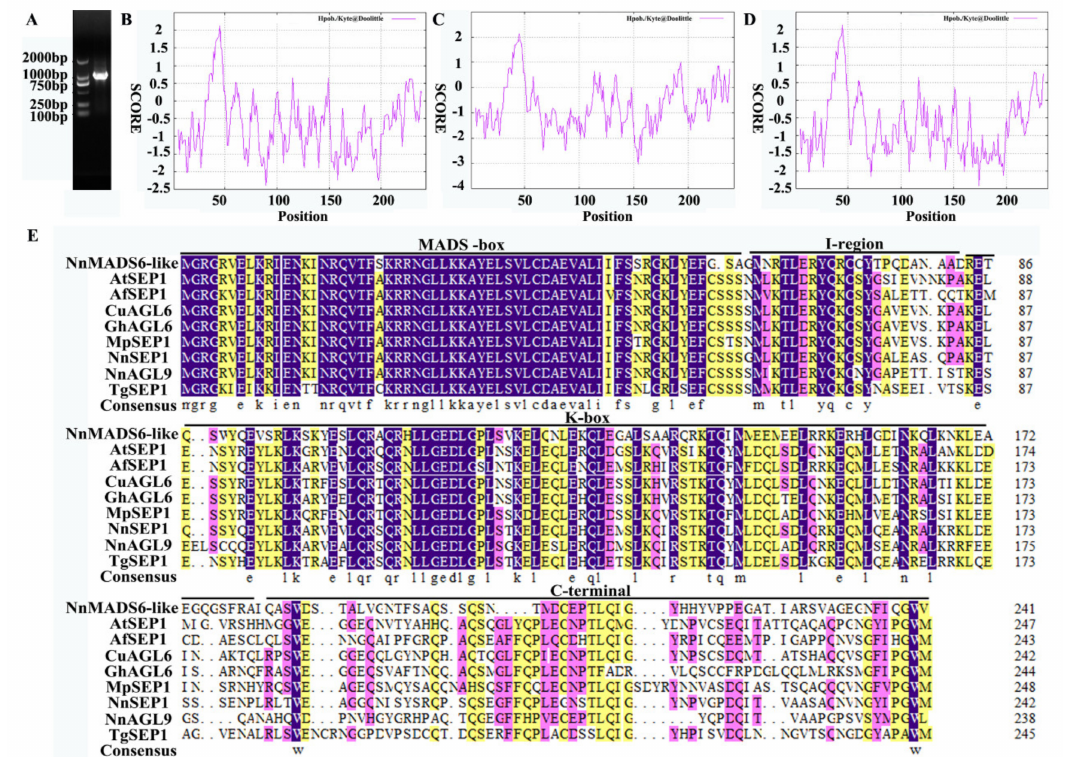
Figure 2. Cloning of three NnSEP genes and predictive analysis of their protein domains. ( A ) Cloning of the full-length cDNA of three NnSEP genes. ( B ) The prediction analysis of ProtScale protein hydrophobicity of NnSEP1. ( C ) The prediction analysis of ProtScale protein hydrophobicity of NnMADS6-like. ( D ) The prediction analysis of ProtScale protein hydrophobicity of NnAGL9. ( E ) Sequence alignment of SEP protein in Nelumbo nucifera and other species. The protein sequences of NnSEP1, NnMADS6-like and NnAGL9 aligned were retrieved from NCBI. Different species and matching GenBank accession numbers are shown below. AtSEP1 from Arabidopsis thaliana (AAU82007.1), AfSEP1 from Aristolochia fimbriata (ALV83431.1), CuAGL6 from Citrus unshiu (GAY42048.1), GhAGL6 from Gossypium hirsutum (XP_040972459.1), MpSEP1 from Medicago polyceratia (AFU81295.1), TgSEP1 from Tulipa gesneriana